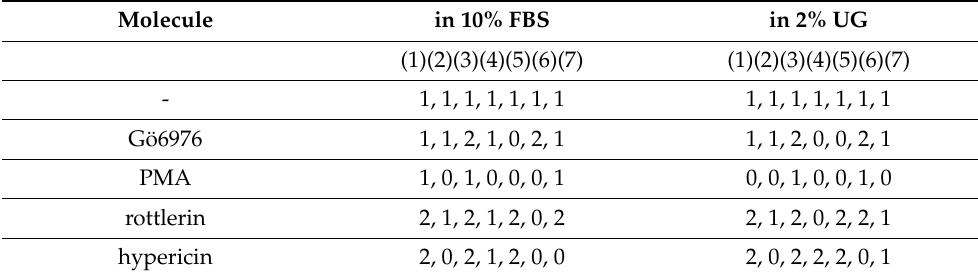
Table 2. Categorical values of features 1–7 related to the regulation of cell death (see Section 2.5) estimated at different levels of lipids in the cultivation media: lipid enrichment (10% FBS) and lipid deficiency (2% UG). 1—base level (control cells), 0—pro-apoptotic, 2—prosurvival stimuli. This table was compiled from the results of previously reported studies (see Ref. Section